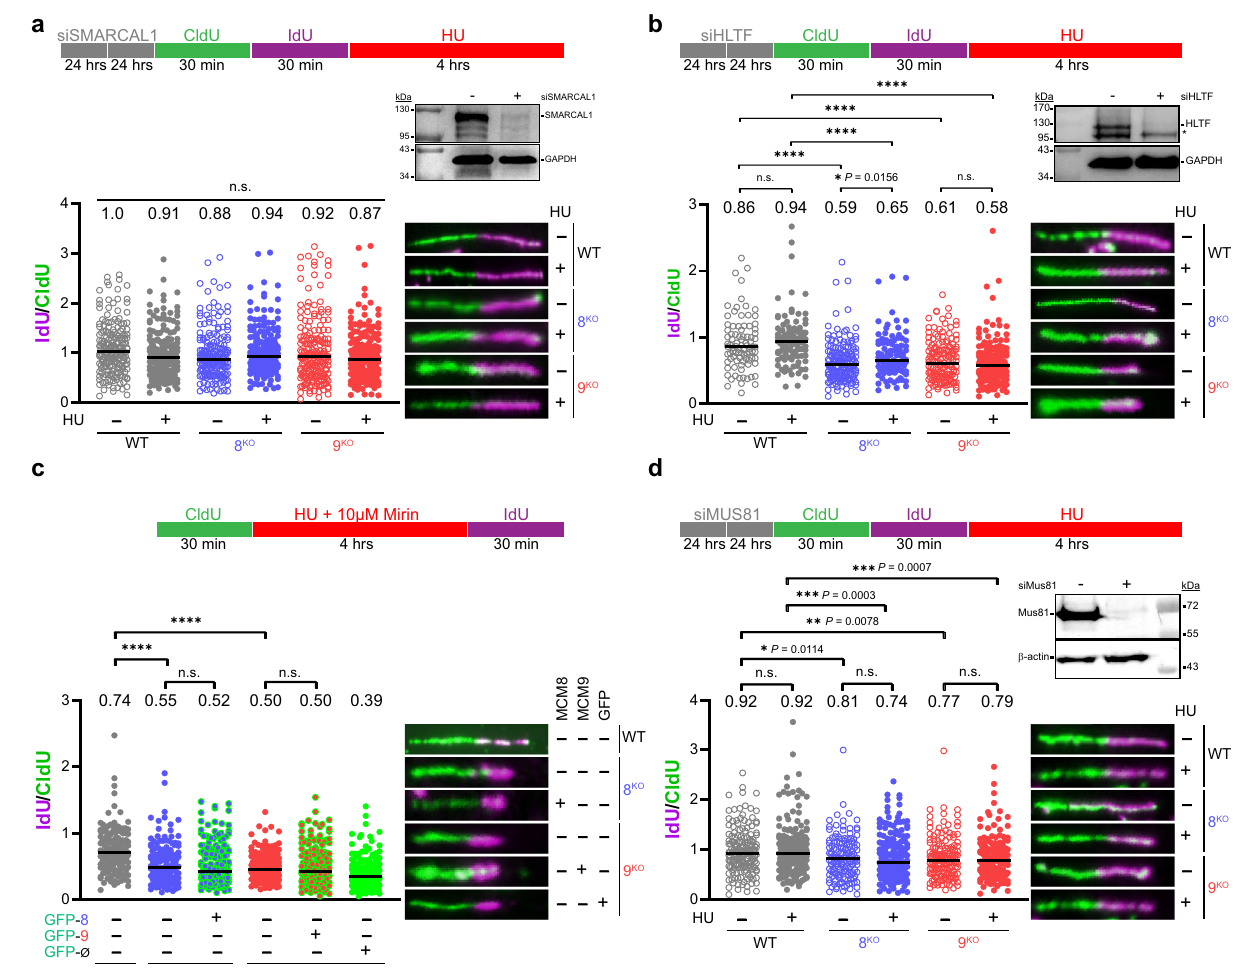
Fig. 5 | MCM8/9 function to direct SMARCAL1-mediated fork reversal and do not actively participate in stalled fork restart. 293T WT (gray), 8 KO (blue),or 9 KO (red) cells were transfected with siRNA twice for 24h each to knockdown a SMARCAL1 (>150 fi bers) or b HLTF (>100 fi bers) and veri fi ed by western blot (*indicates a nonspeci fi c band on the HLTF blot). Cells were then sequentially incubated with CldU and IdU for the indicated time intervals ( ○ ) or followed by 2mM HU for 4h ( ● ). DNA was spread by gravity to measure NSD by quantifying fi ber lengths using Image J. c Cells were treated with 2mM HU and 10 µ M mirin for 4h to monitor fork restart as fl anked by CldU and IdU labeling for indicated time